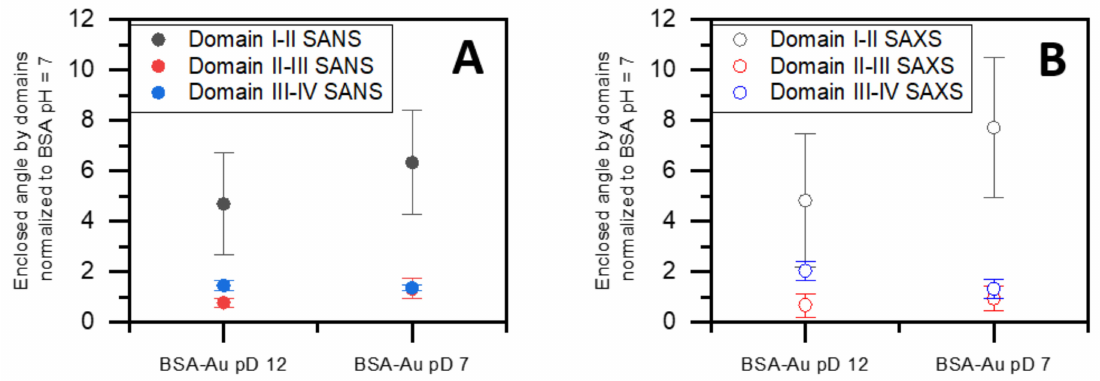
Figure 7. Enclosed angle by domain I–II, II–III, and III–IV obtained by SASREF from SANS ( A ) and SAXS ( B )